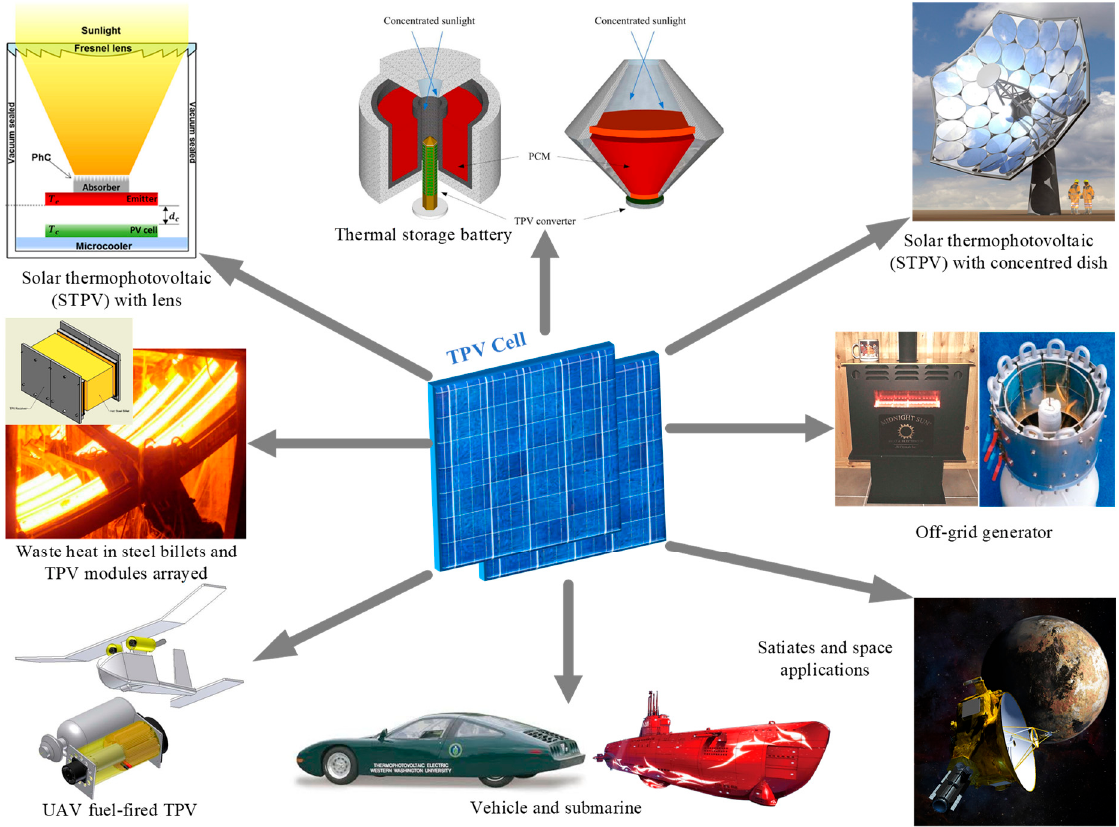
Figure 4. TPV applications.